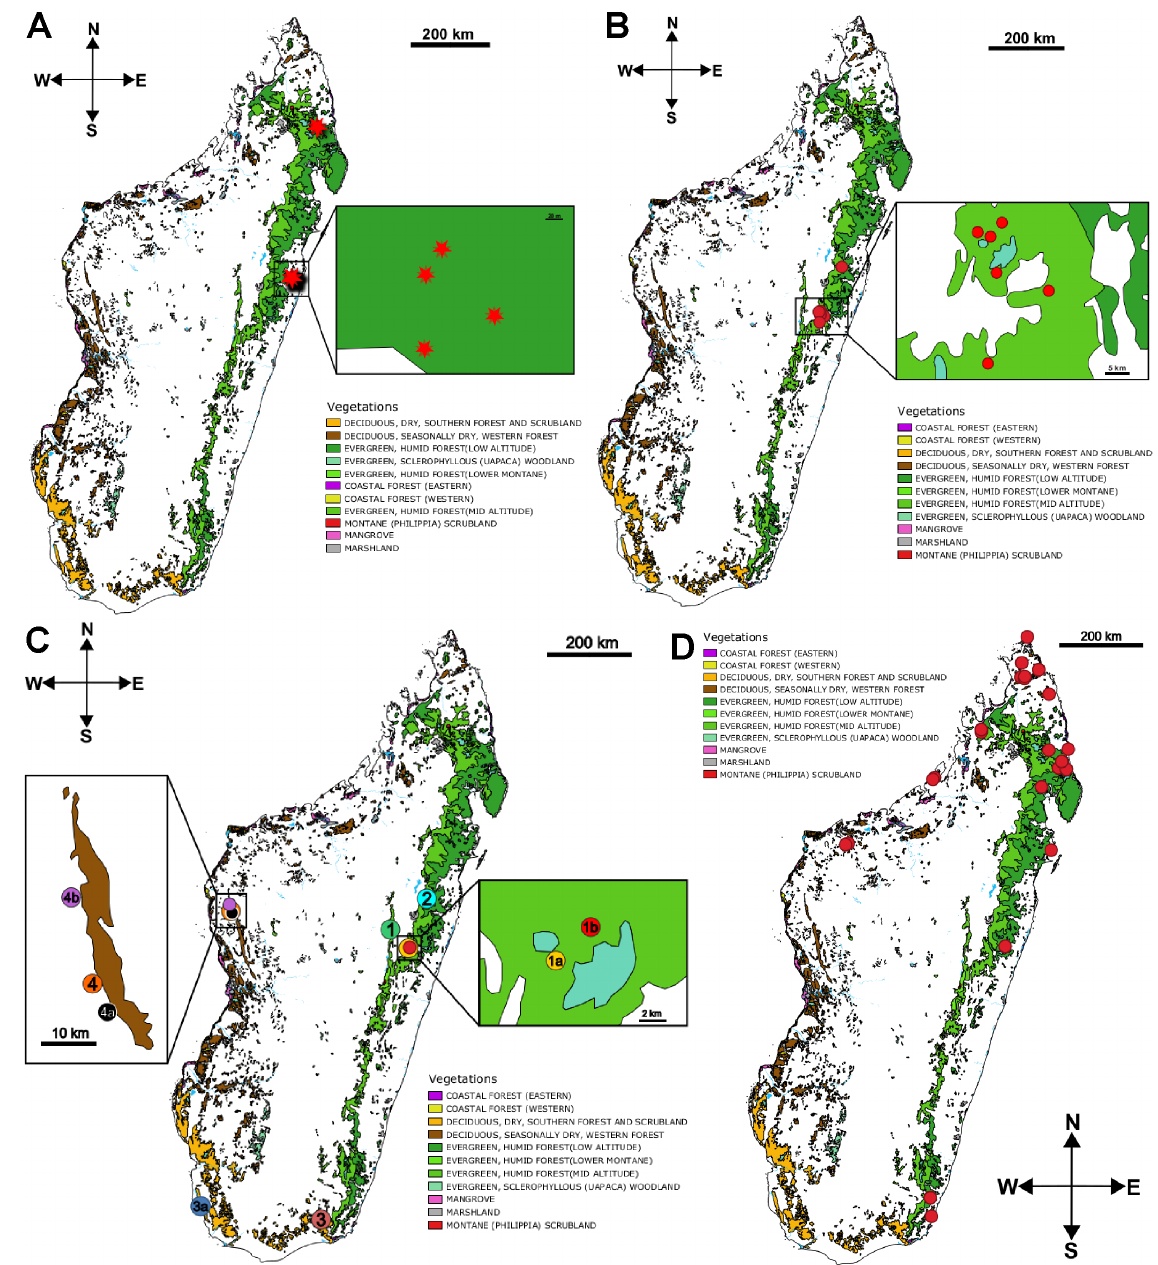
Fig. 13. Distribution maps marking new localities for known species of Zoosphaerium . Vegetation color marks modified from Moat & Smith 2007. A . Z. neptunus (Butler, 1872). B . Z. platylabum (de Saussure